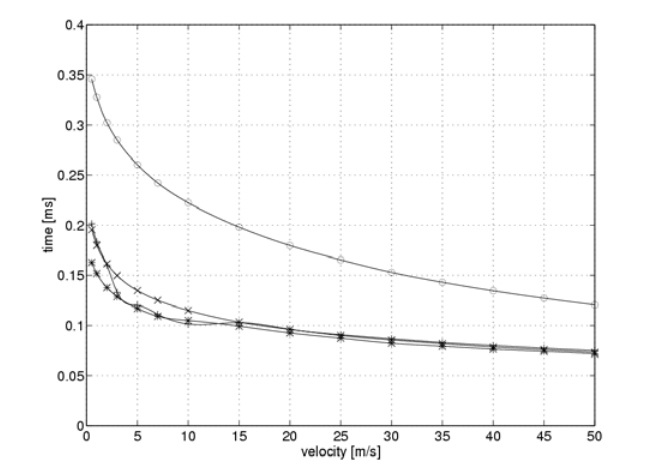
Figure 5. Reaching steady state when switching over to the lower heating level ("*" - optimal, "o" - minimum, "+" – intermediate, "x" – maximum gain